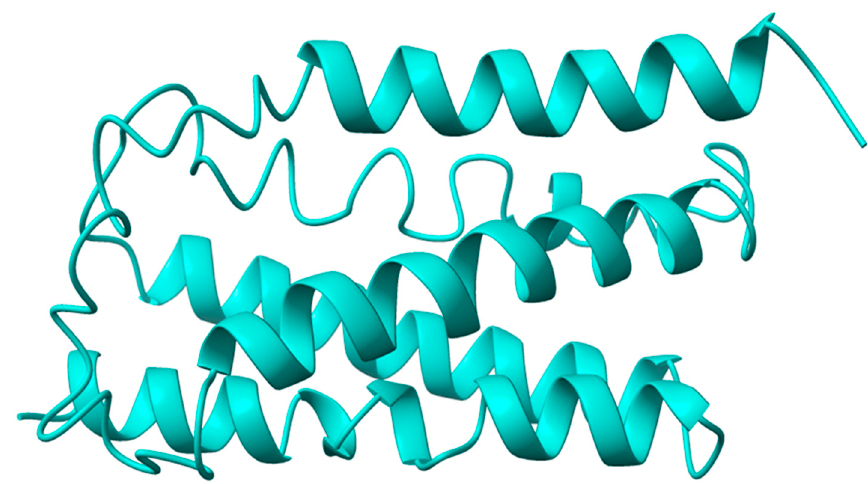
Figure 1. I-TASSER-server-based predicted structure of the VanZ protein. The prediction was re- peated in the same server three times.